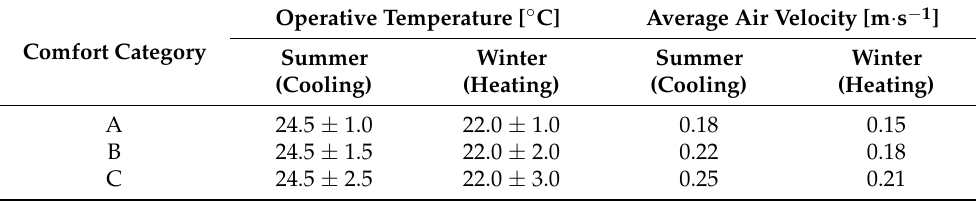
Table A1. Comfort categories according to standards MSZ CR 1752: